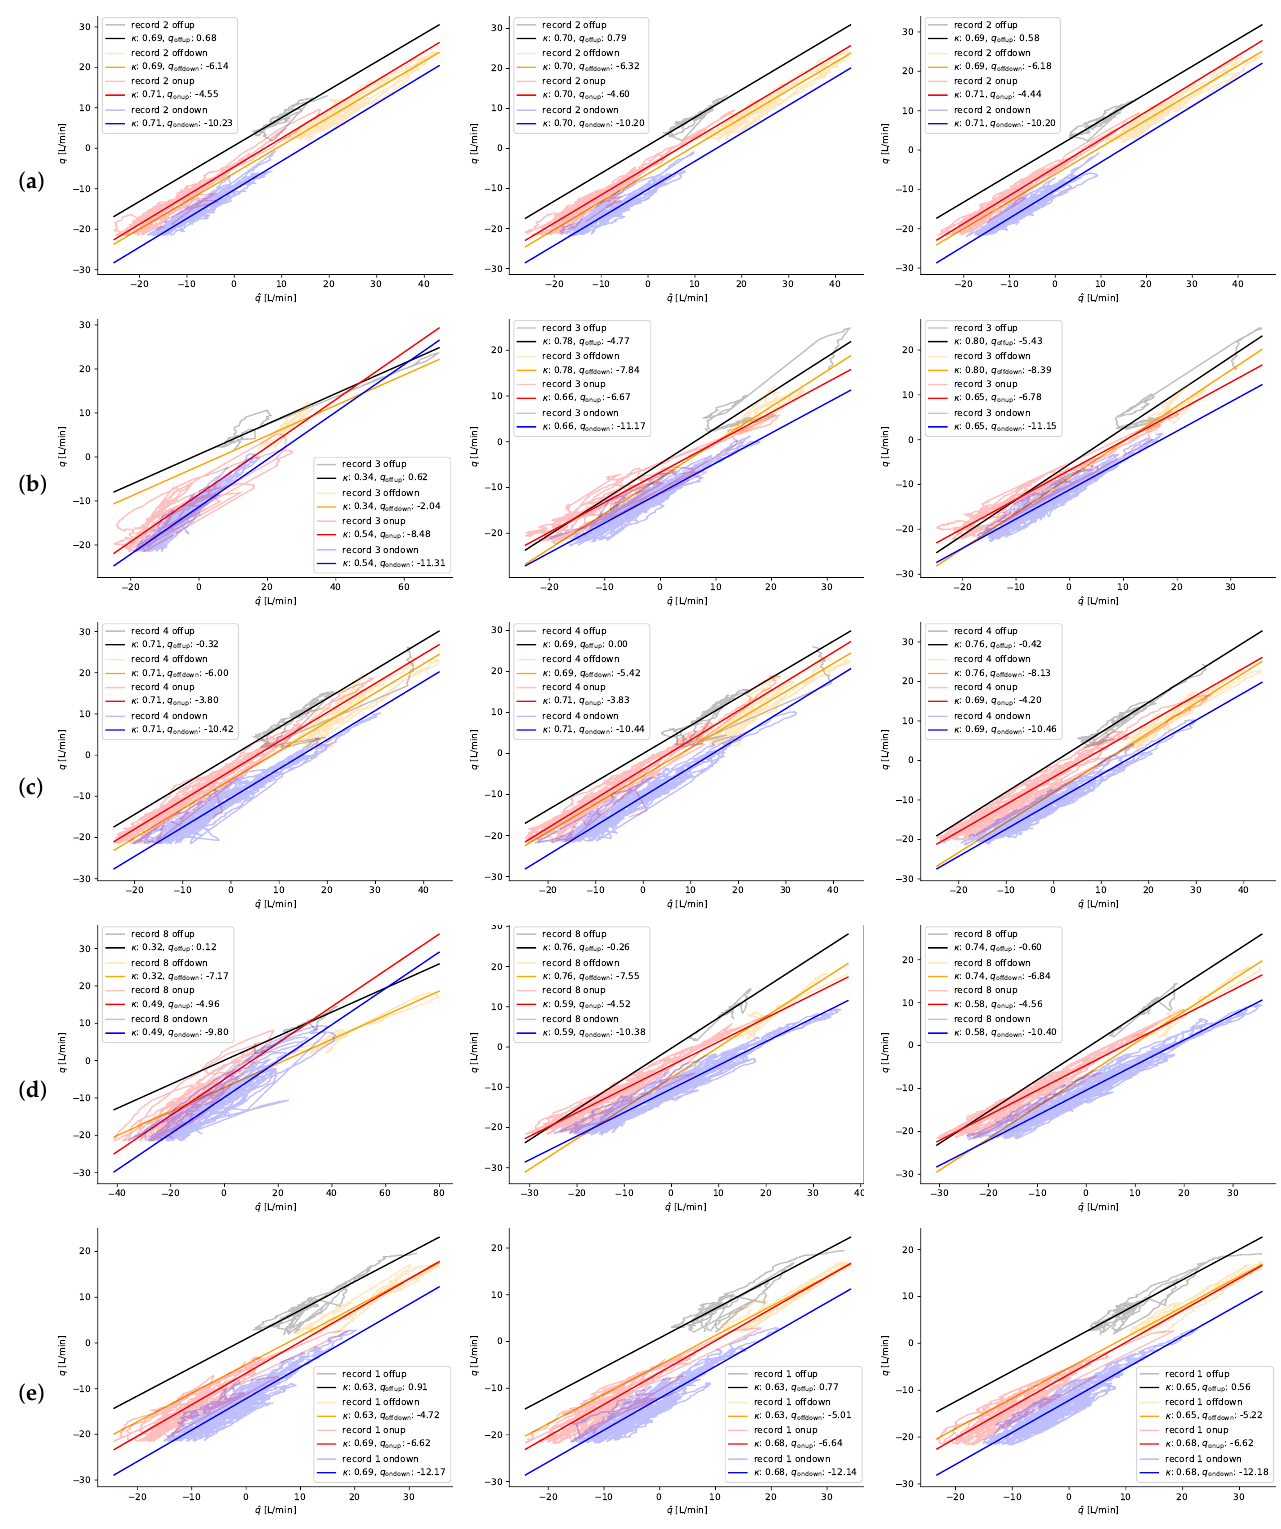
Figure 12. Flow rate estimation comparison with some 10 minute simulations and (a) nominal conditions, (b) a piston seal leak at blade 1, (c) extra friction at blade 3, (d) 50% loss of nitrogen at blade 1 and (e) 6 L/min loss of pump flow.